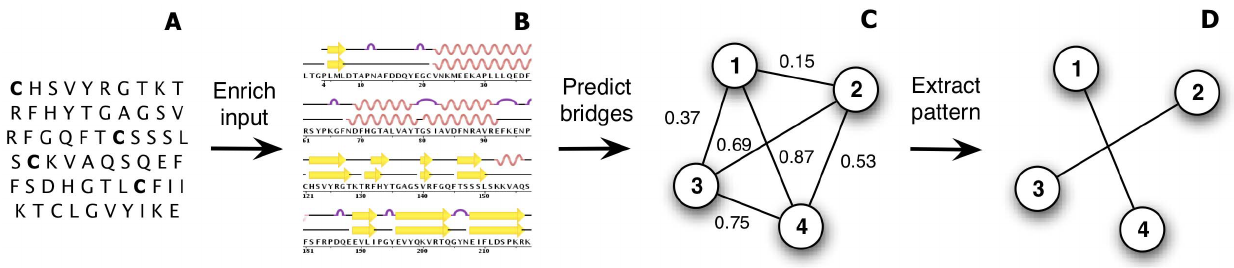
Figure 1. Three-step approach for disulfide pattern prediction. (A) an input primary structure, which contains four cysteine residues. (B) The sequence is first enriched using evolutionary information and sometimes structural-related predictions such as the secondary structure. (C) A bridge classifier, then, predicts disulfide bonding probabilities for each cysteine pair and finally (D) a graph matching algorithm extracts the disulfide pattern with maximal